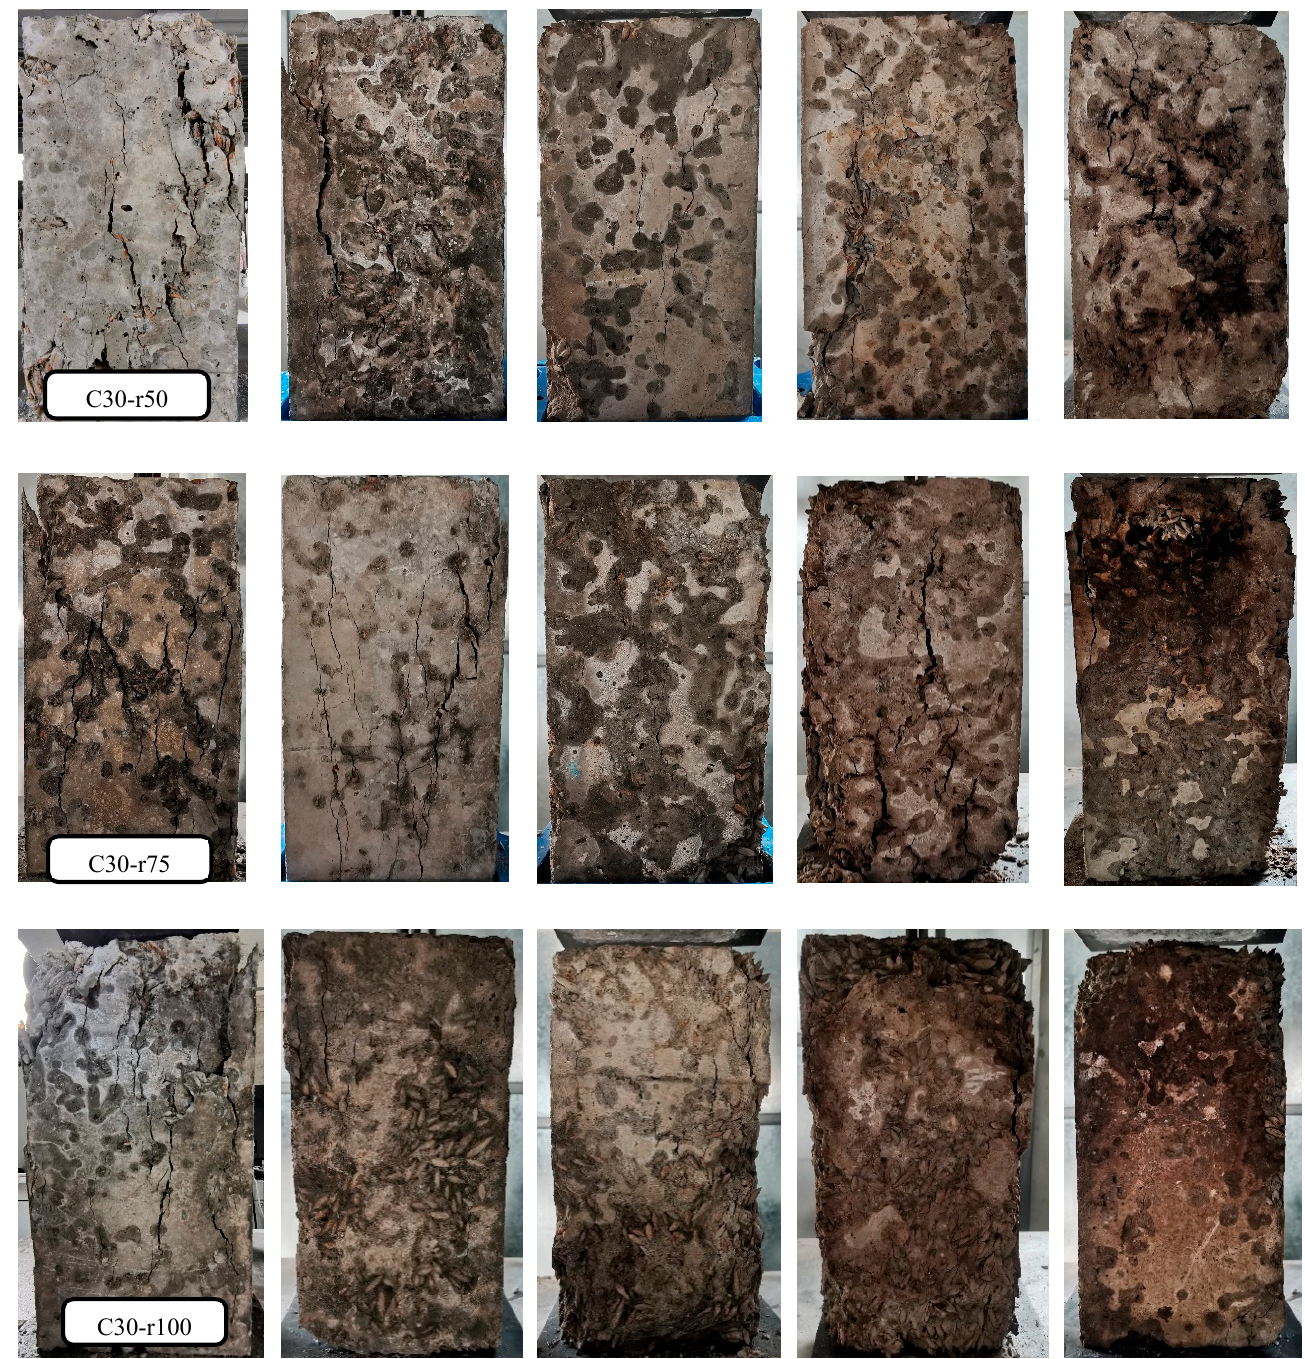
Figure 5. Failure phenomenon of the uniaxial compressive strength test.